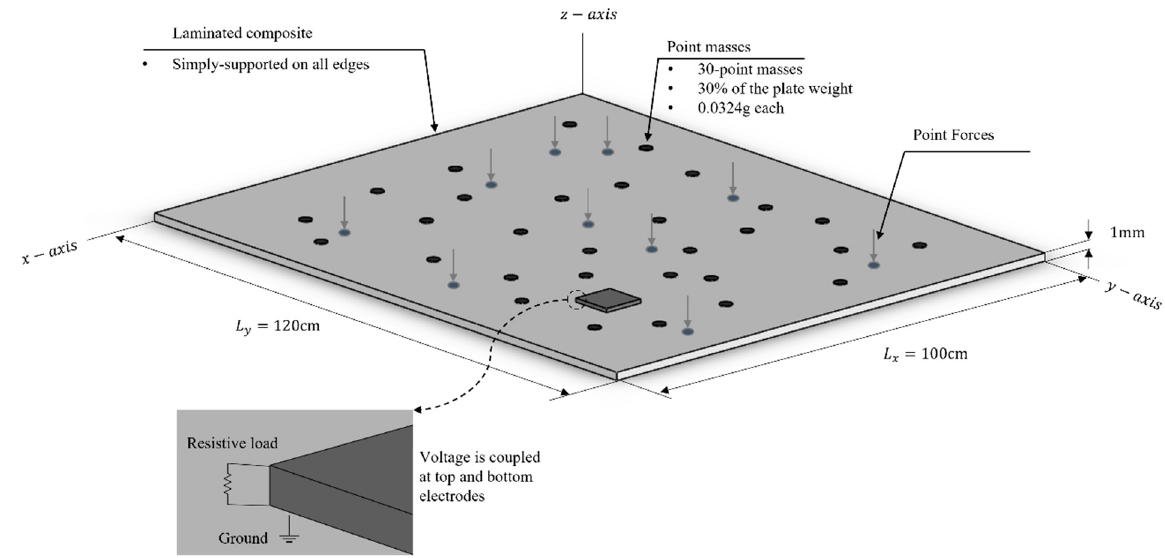
Figure 4. Benchmark model.